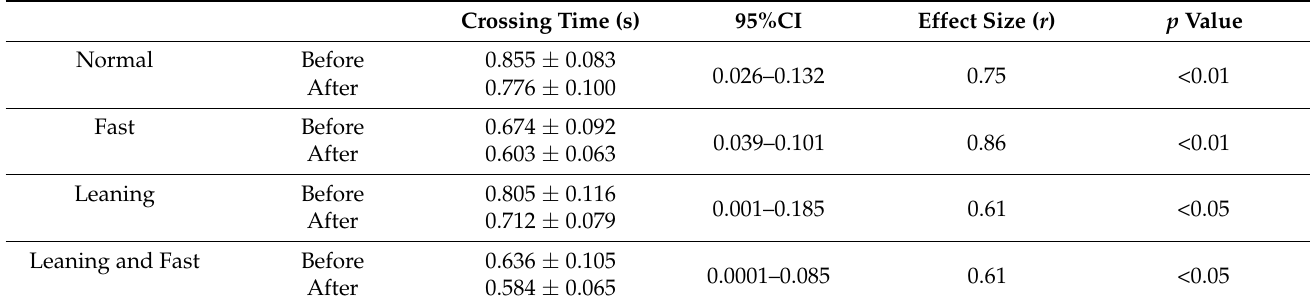
Table 8. Crossing time in the STG for heel in lateral obstacle crossing.